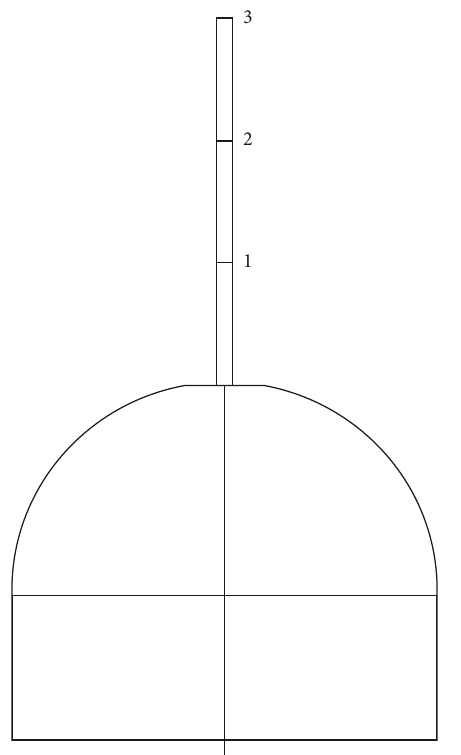
Figure 8: Measurement point for the deep displacement of sur- rounding